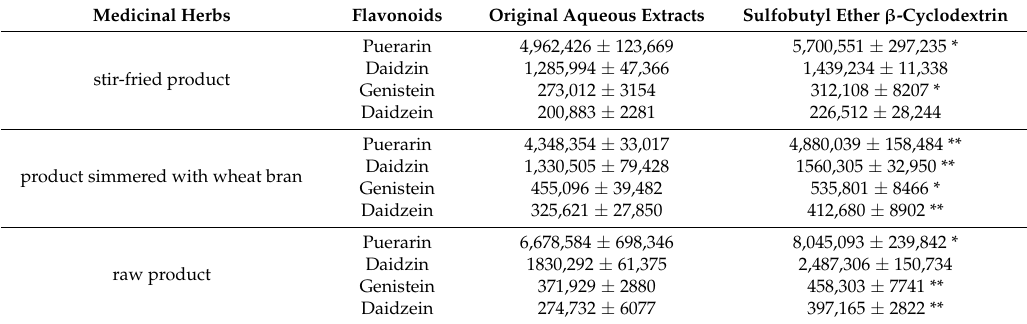
Table 4. Associated-extraction efficiency of sulfobutyl ether β -cyclodextrin for flavonoids from different processed products of PLR (peak area, n = 3).